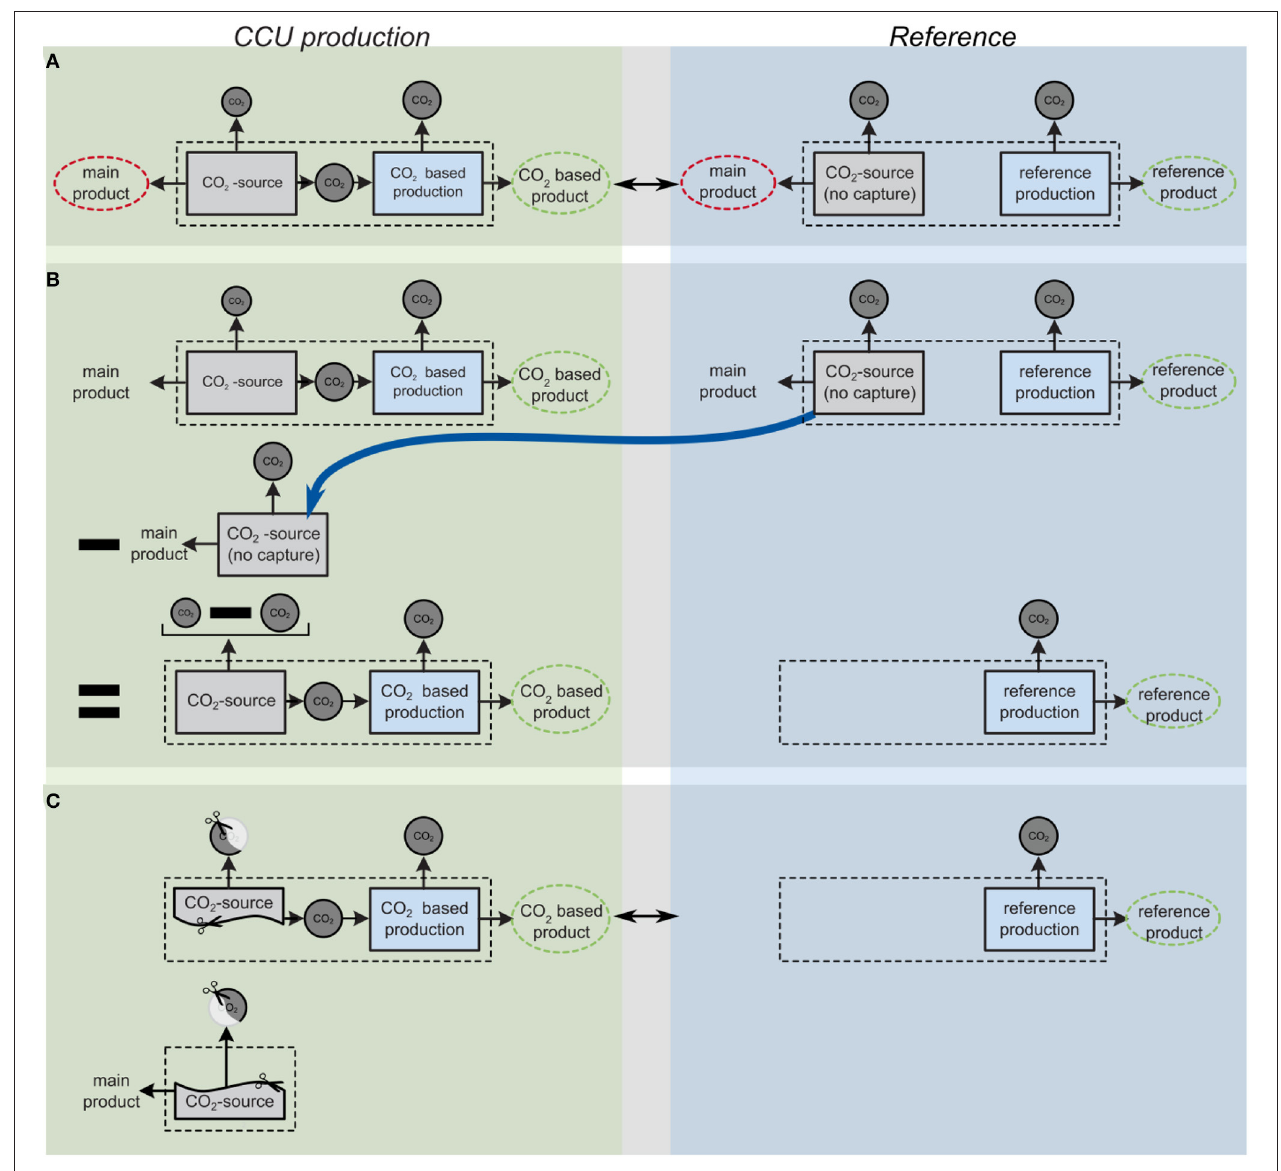
FIGURE 7 | (A) Comparison of a CCU production and a reference production: CCU system produces a main product besides CO 2 -based product, i.e., the CCU system has additional function (dashed red line) besides functional unit (dashed green line). Thus, the conventional and CCU system are not comparable due to different functions. System expansion enables the comparison of the CCU production and the reference production by including the main product of CO 2 -source in functional unit. For a sound comparison the reference production system is expanded with the conventional production of the main product without carbon